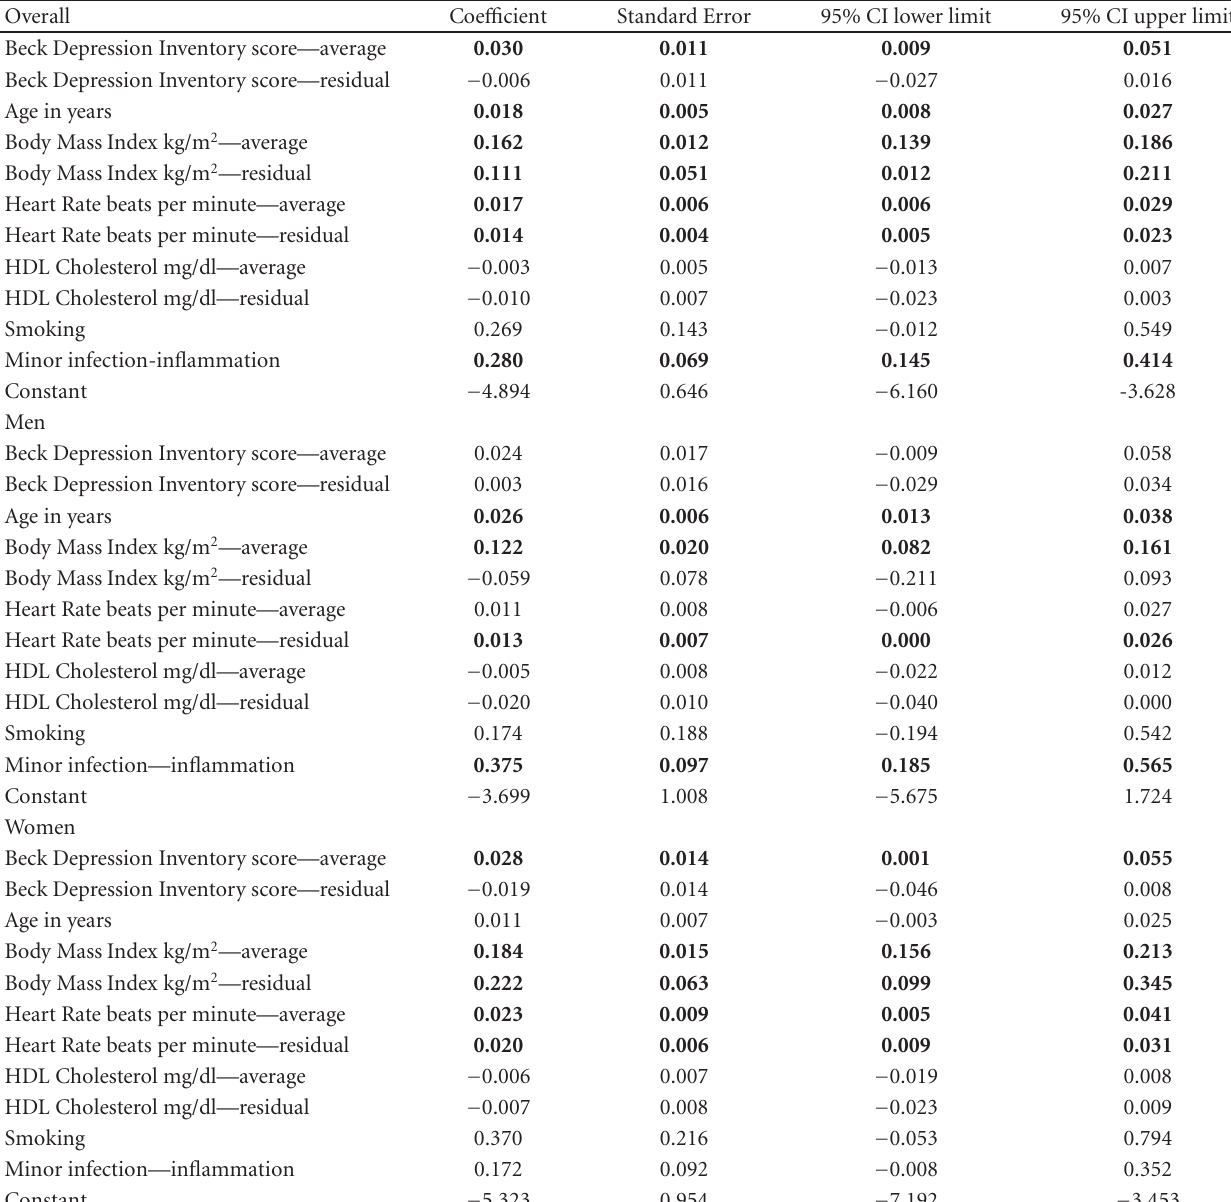
Table 2: Multivariable Linear Mixed Model Predicting High Sensitivity C-Reactive Protein, SEASONS Study. Worcester MA,